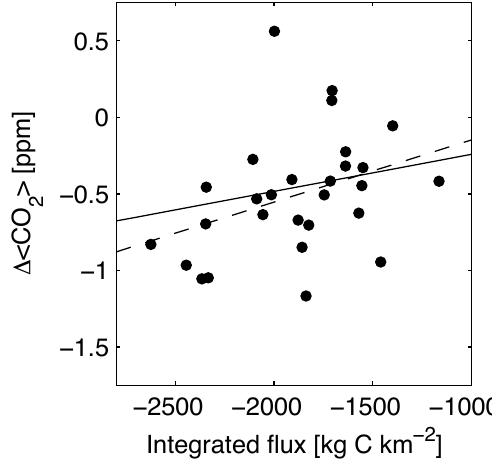
Fig. 5. Relationship between daytime 1 h CO 2 i bio (15:00 minus 08:00) and daytime NEE at the gridbox corresponding to Park Falls, Wisconsin in June. The dashed line represents the best fit to the data, but it accounts for only 12% of the variance (as determined by R 2 ). The solid line represents the change expected in h CO 2 i due to the surface flux alone.